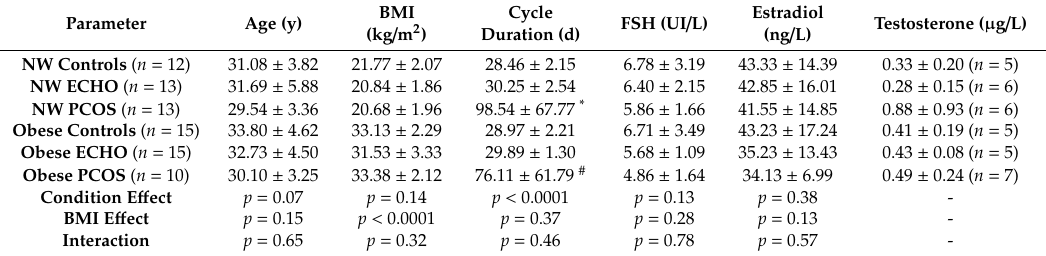
Table 1. Study population’s ( n = 78) clinical parameters, hormonal data, and in vitro fertilization procedure outcomes.